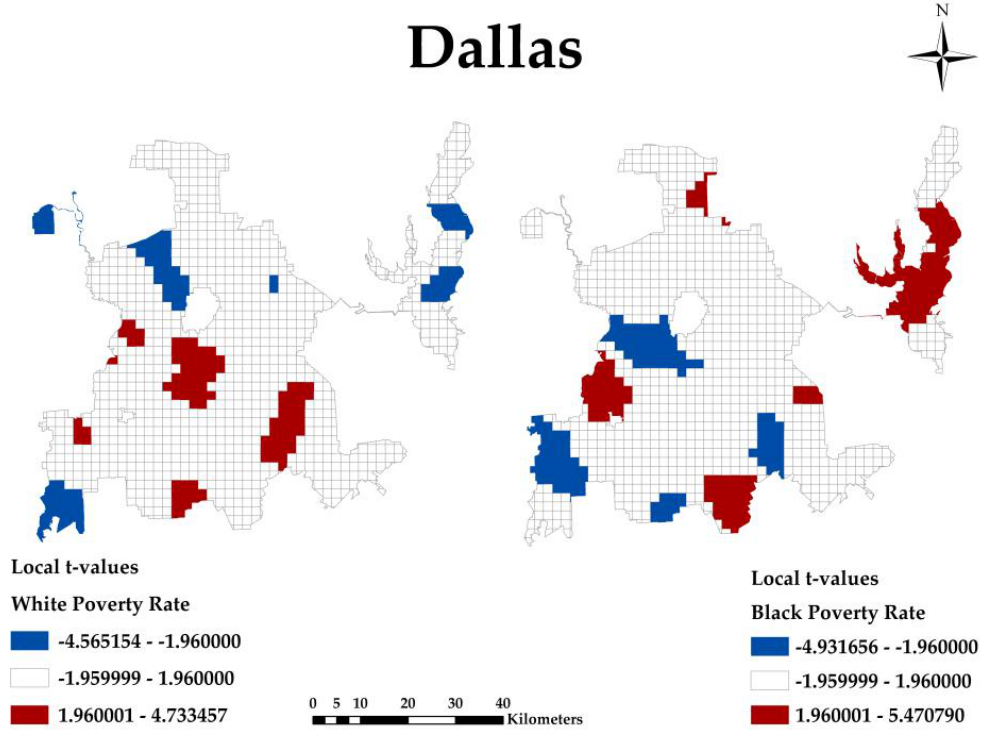
Figure 12. Philadelphia shrinking city Percent White and Percent Black: 95% two-tailed test (−1.96:1.96) for 2010.